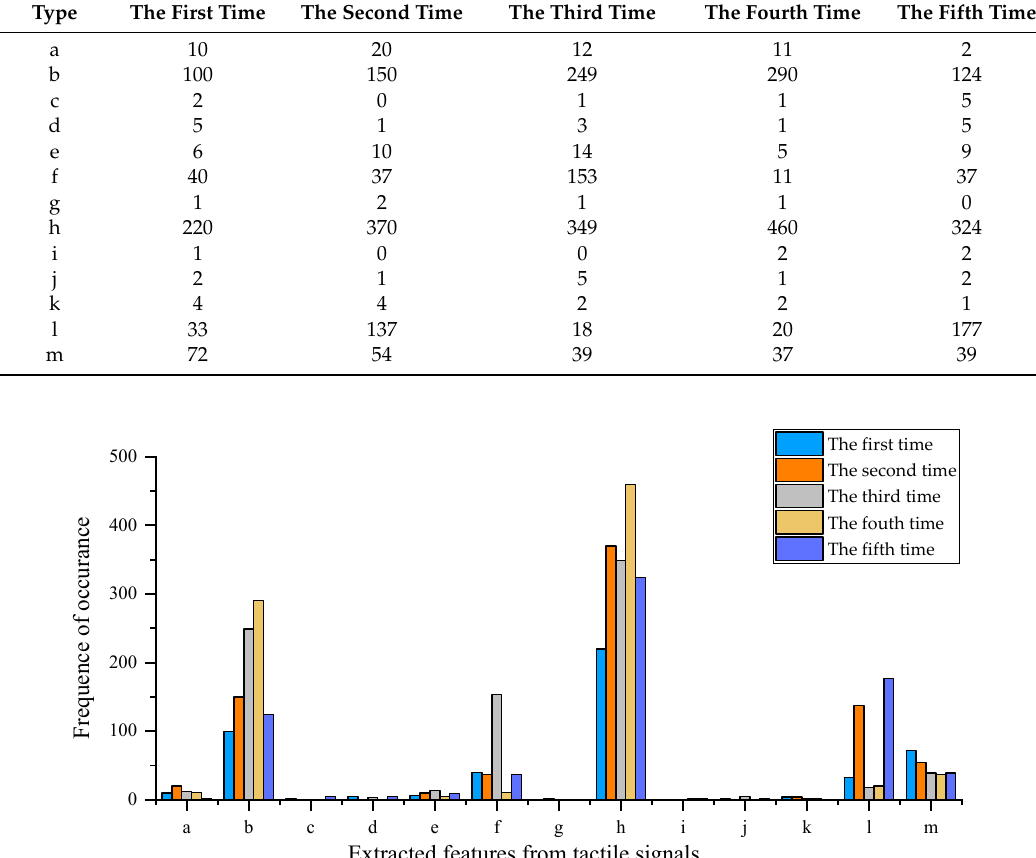
Figure 5. Resulting plot of five times feature selection using the genetic algorithm. Table 8. Results of five times feature selection using the genetic algorithm.